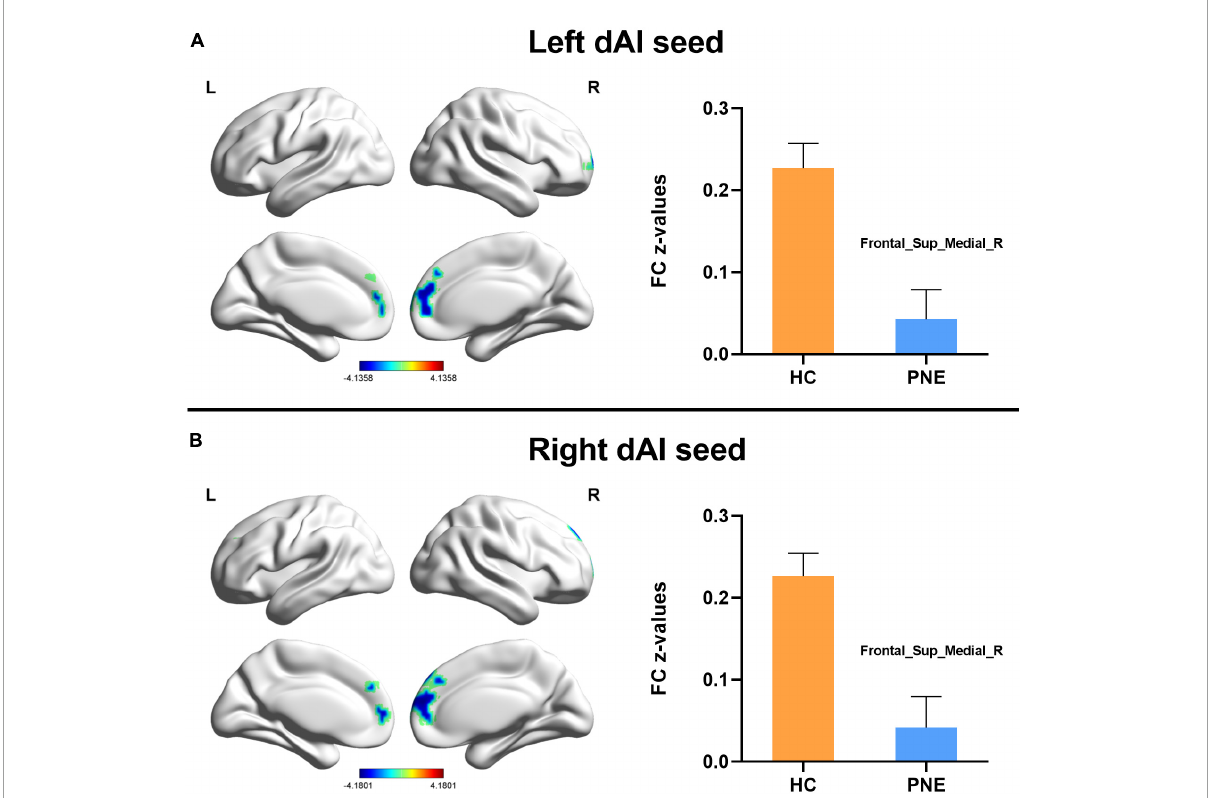
FIGURE2 Comparisons of the dorsal anterior insula-centered functional connectivity between PNE and HC children. The (A) left and (B) right dAI seeds indicated reduced functional connectivity with Frontal_Sup_Medial_R (two-tailed GRF correction, P < 0.005 at single voxel, and P < 0.05 at cluster level). PNE, primary nocturnal enuresis; HC, healthy control; dAI, dorsal anterior insula; Frontal_Sup_Medial, medial superior frontal gyrus; L, left; R, right. Color scales: t -value; Error bars: SEM.